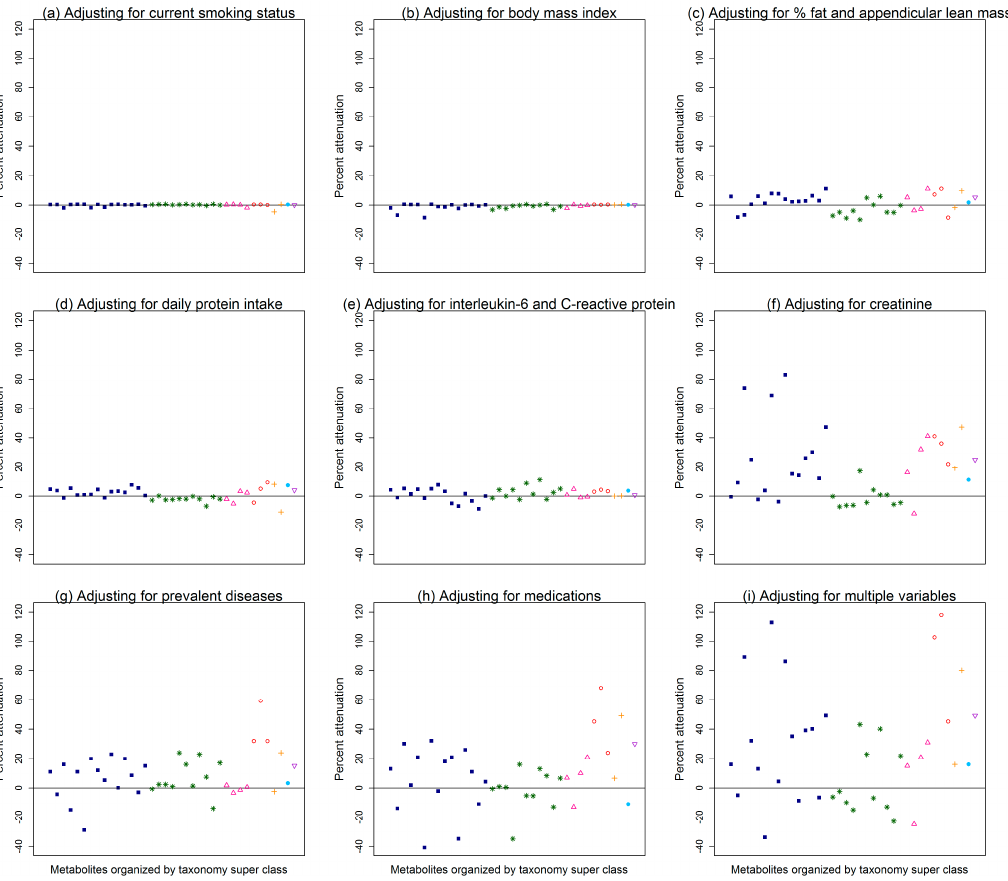
Figure 1. Percent attenuations of the age- and study side- adjusted correlation between 37 metabolites (organized by Human Metabolome Database taxonomy super class) and scores on